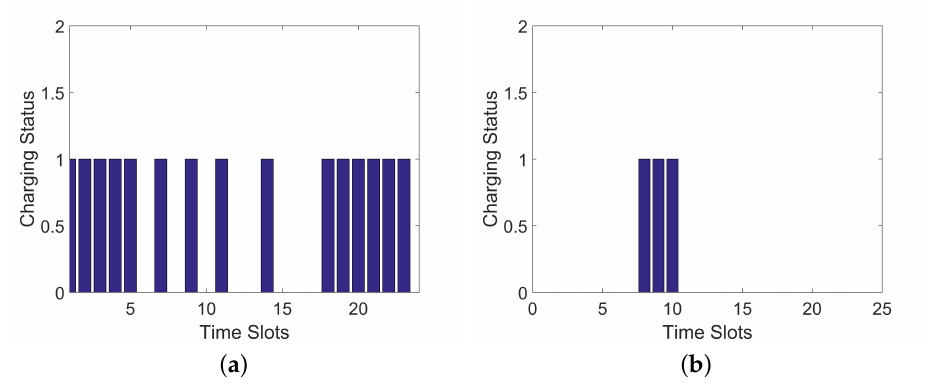
Figure 10. A comparison between rolling optimization and fixed-plan optimization. ( a ) Charging Schedule by rolling optimization for the first day and ( b ) Charging Schedule by fixed-plan for the first